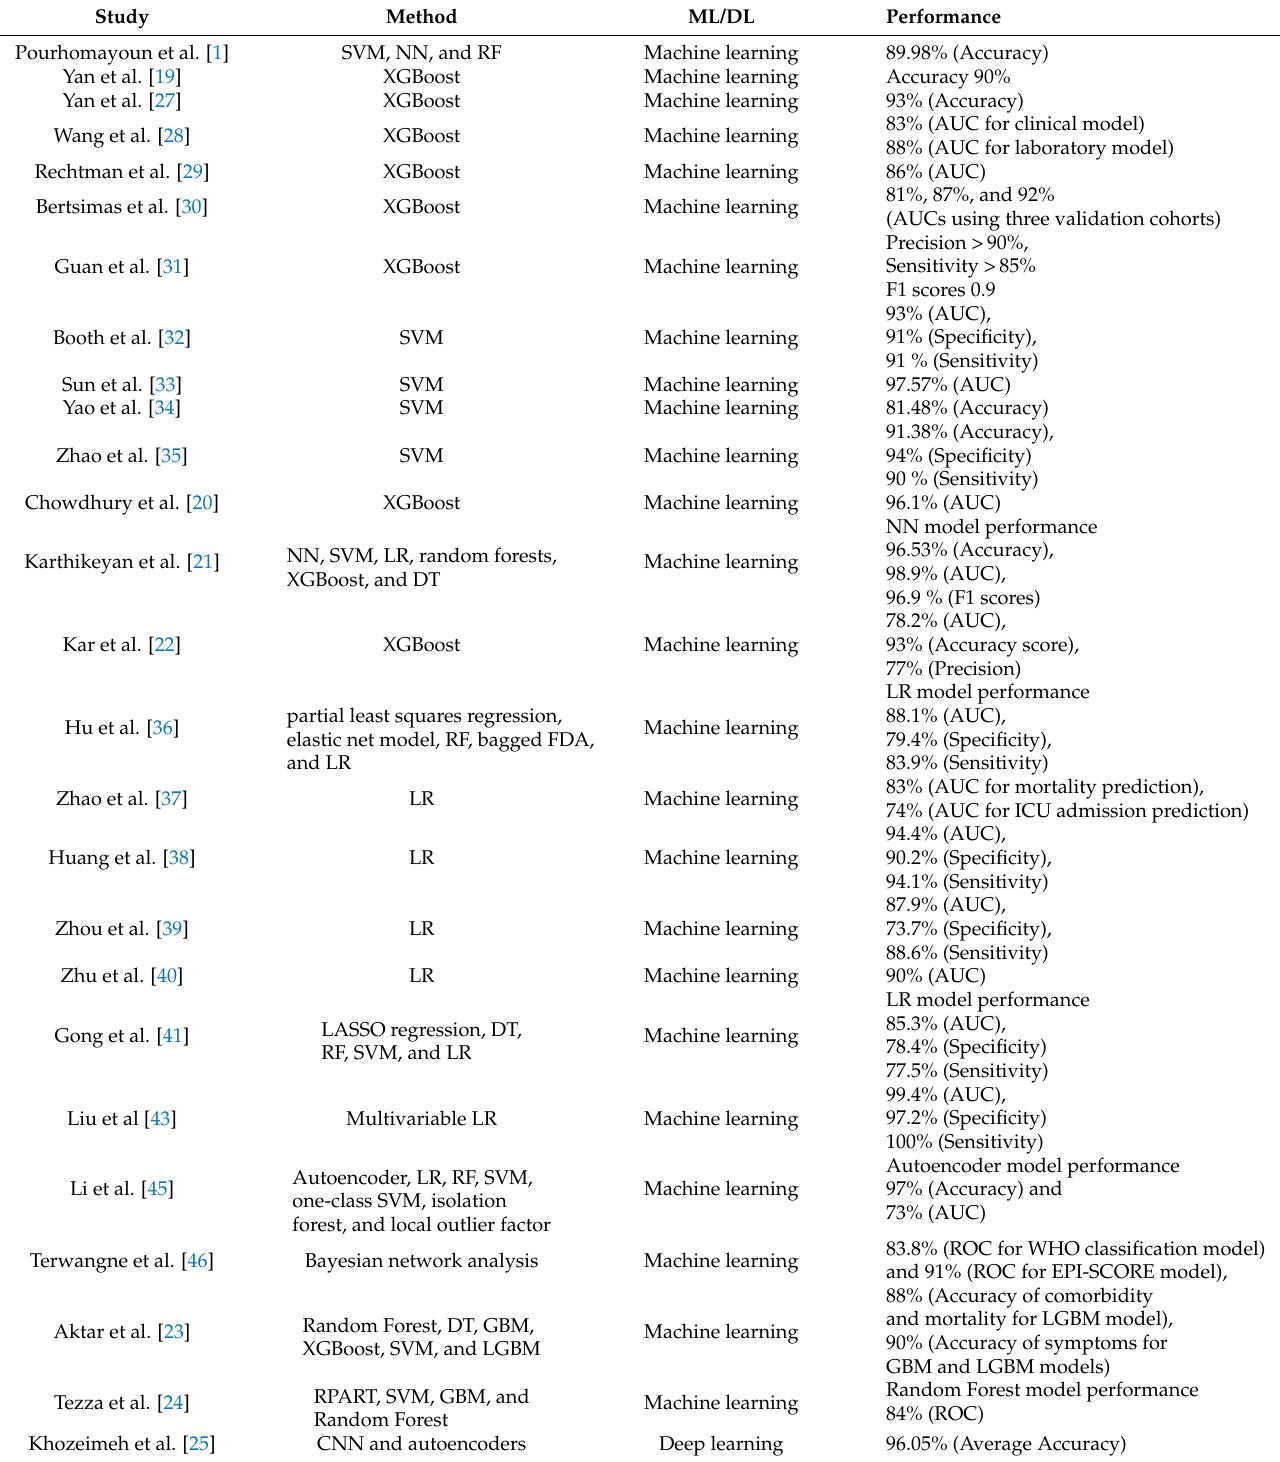
Table 1. Summary of the commonly reviewed studies on the severity and the prediction of mortality risk in COVID-19